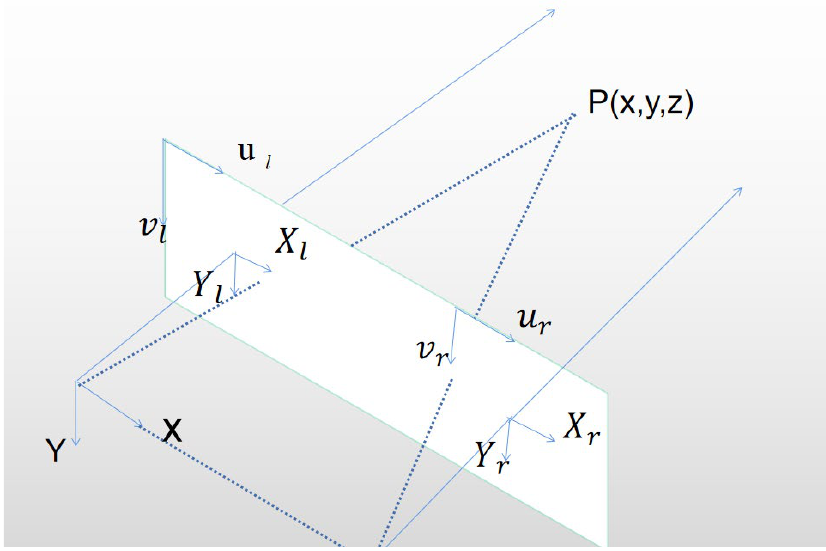
Figure 7. Binocular stereo locating model.